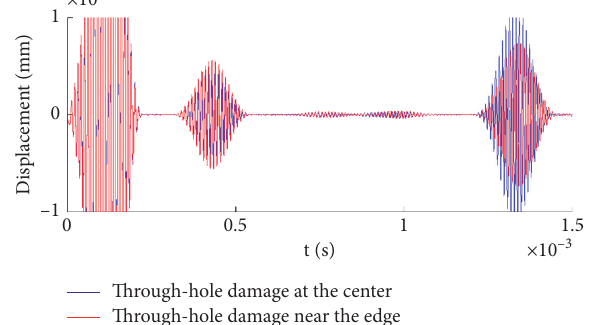
Figure 14: Time domain waveforms received from a hexagonal pipe with through-hole damages located at the center and near the edge of a